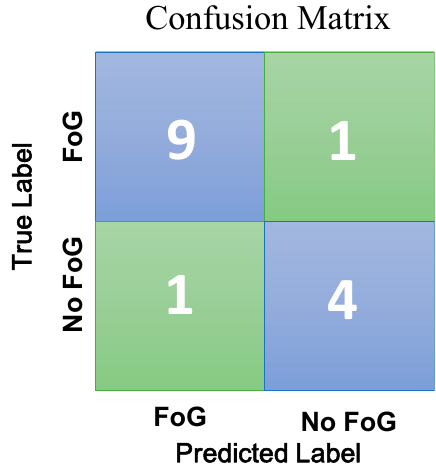
Figure 10. Confusion matrix for the proposed approach.